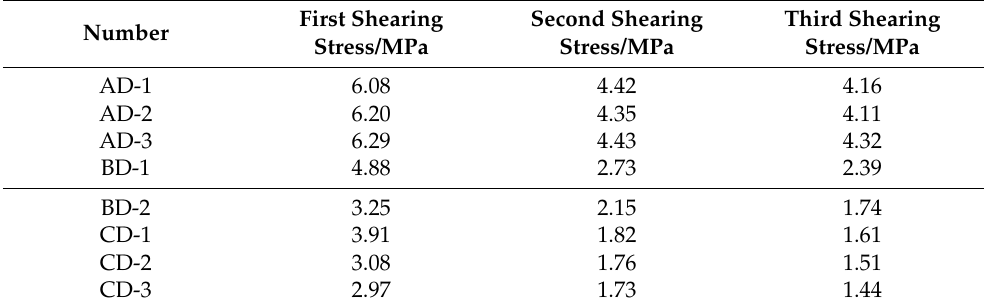
Table 3. The shear strength of different rock–mortar interfaces subjected to cyclic shearing.